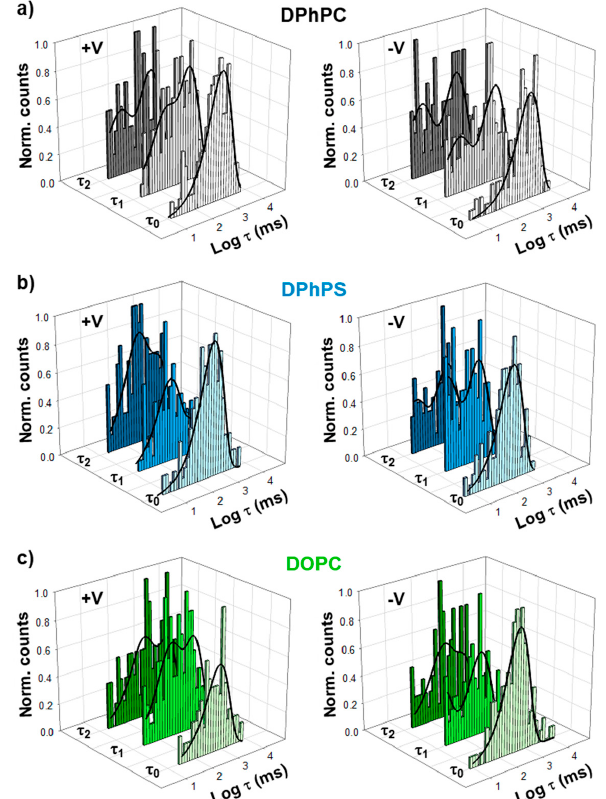
Figure 5. Gating kinetics for the second and third monomer closures display higher complexity than